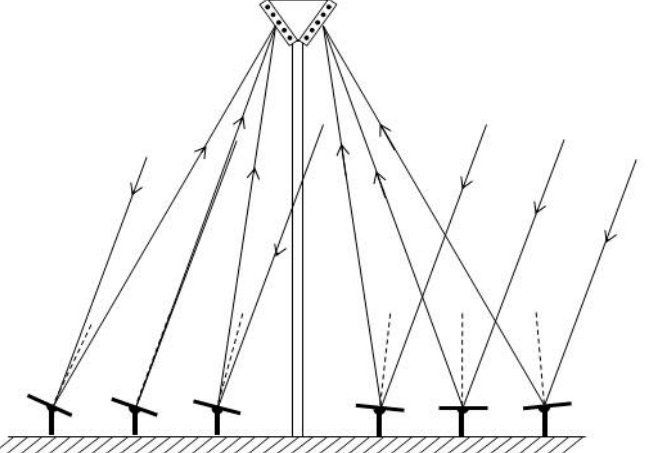
Figure 1. A reflection Fresnel collector sketch with two receivers, which can have parallel fluid circuits or series ones, going back and forth [49]. This scheme can be considered the state of the art of these collectors. Mirrors must rotate on an axis to maintain focus.